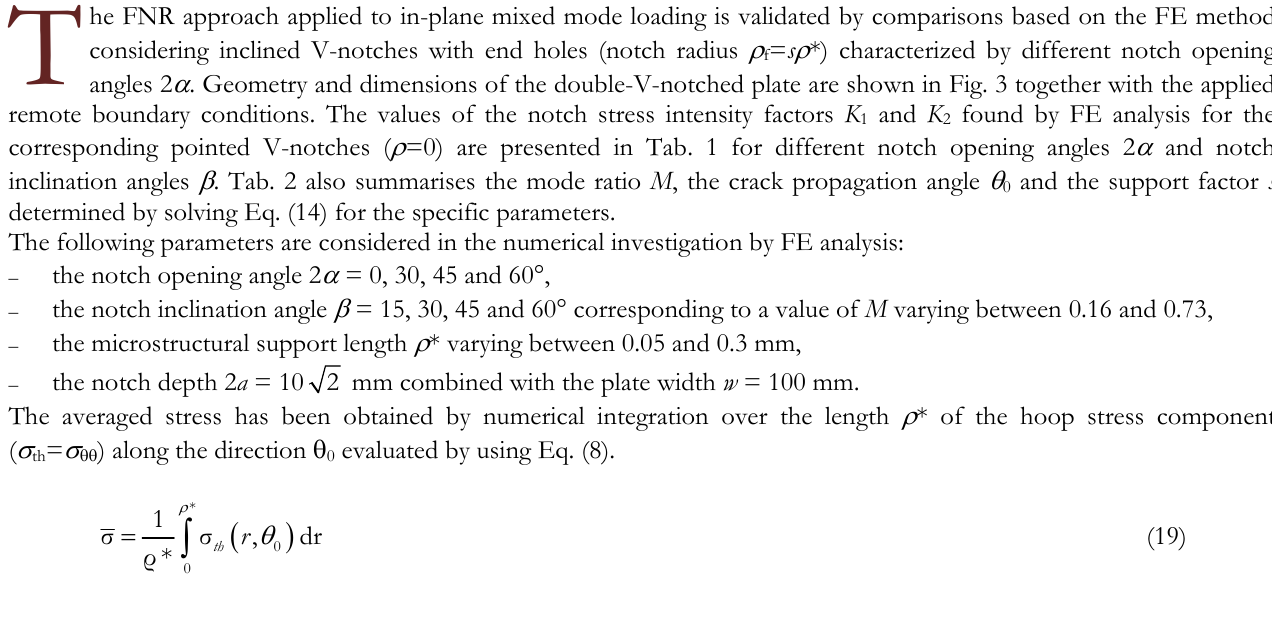
V ALIDATION OF THE PROPOSED FNR APPROACH FOR MIXED MODE LOADING CONDITIONS he FNR approach applied to in-plane mixed mode loading is validated by comparisons based on the FE method considering inclined V-notches with end holes (notch radius  f = s  *) characterized by different notch opening angles 2  . Geometry and dimensions of the double-V-notched plate are shown in Fig. 3 together with the applied remote boundary conditions. The values of the notch stress intensity factors K 1 and K 2 found by FE analysis for the corresponding pointed V-notches (  =0) are presented in Tab. 1 for different notch opening angles 2  and